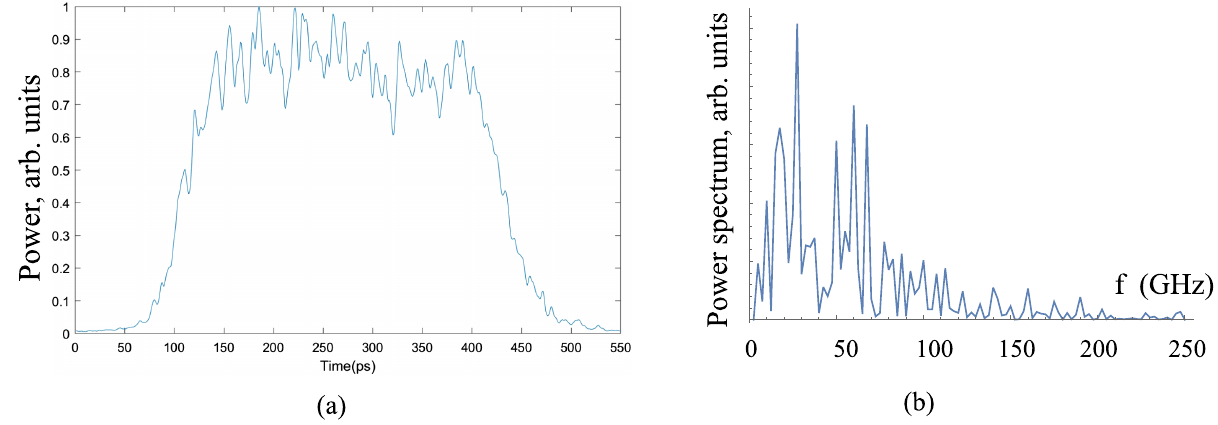
FIG. 23. (a) The profile of the second harmonic (green) laser pulse measured by a streak camera having a resolution of a few psec and (b) the spectrum of this